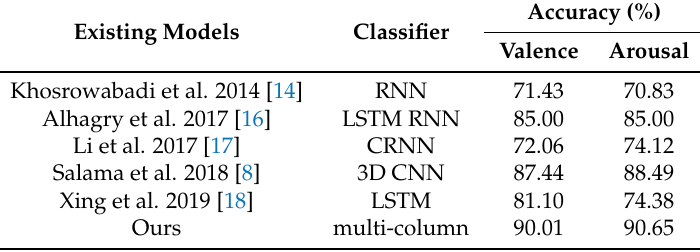
Table 7. Comparison to existing models that recognizes valence and arousal using DEAP